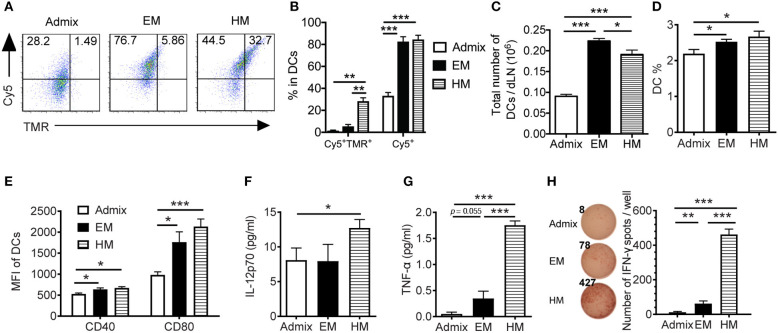
IS-SNAs enhances antigen and CpG co-delivery, thereby promoting DC activation and cross-presentation in vivo. (A,B) For co-delivery evaluation, mice were injected subcutaneously with TMR-labeled PSA65−73 and Cy5-labeled CpG in the form of admix, EM or HM IS-SNAs. Fluorescence signals of CD11c+ DCs in dLNs were measured after 2 h by flow cytometry. The uptake (3 mice per group) was shown by representative dot plots (A) and bar graph (B). (C–H) For DC activation and cross-presentation, dLNs (4 mice per group) were harvested and analyzed 24 h after IS-SNA/PSA65−73 administration. Total number (C) and percentage (D) of CD11c+ DCs in dLNs and the expression of co-stimulatory molecule CD40 and CD80 (E) of these DCs were analyzed by flow cytometry. (F–H) Purified DCs from dLNs were co-cultured with PSA65−73 specific CD8+ T cells at 1:2 ratio for 48 h. The supernatant from the co-culture were harvested for analyzing IL-12 (F) and TNF-α (G) production. (H) The DC cross-presentation ability was evaluated using IFN-γ ELISPOT assay. All data are presented as mean ± SEM. *p < 0.05, **p < 0.01, and ***p < 0.001, analyzed by two-tailed unpaired Student's t-test.